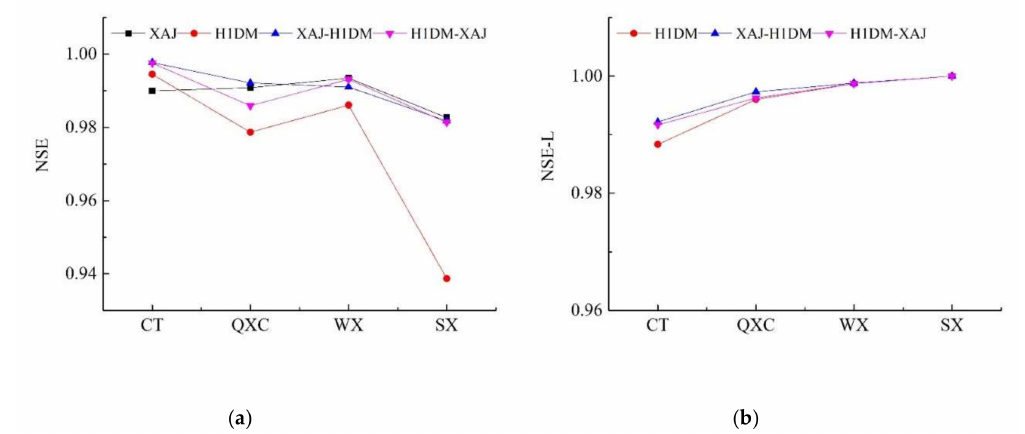
Figure 10. Average NSE ( a ) and NSE-L ( b ) of the four sites for all